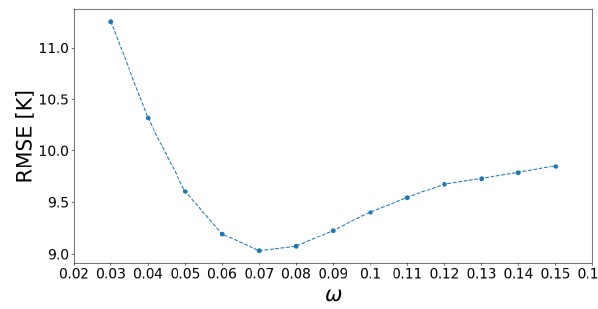
Figure 3. Overall T B RMSE (at 11, 19, and 37GHz, for the 12 sites and for the summer period) between the simulated and measured T BTOA as a function of the values of ω . A σ s value at 0.2cm gives the best results but T B RMSE is not very sensitive to this variable. The parameters β ν and η ν were optimized for each ( ω , σ s ) couple according to the frequency